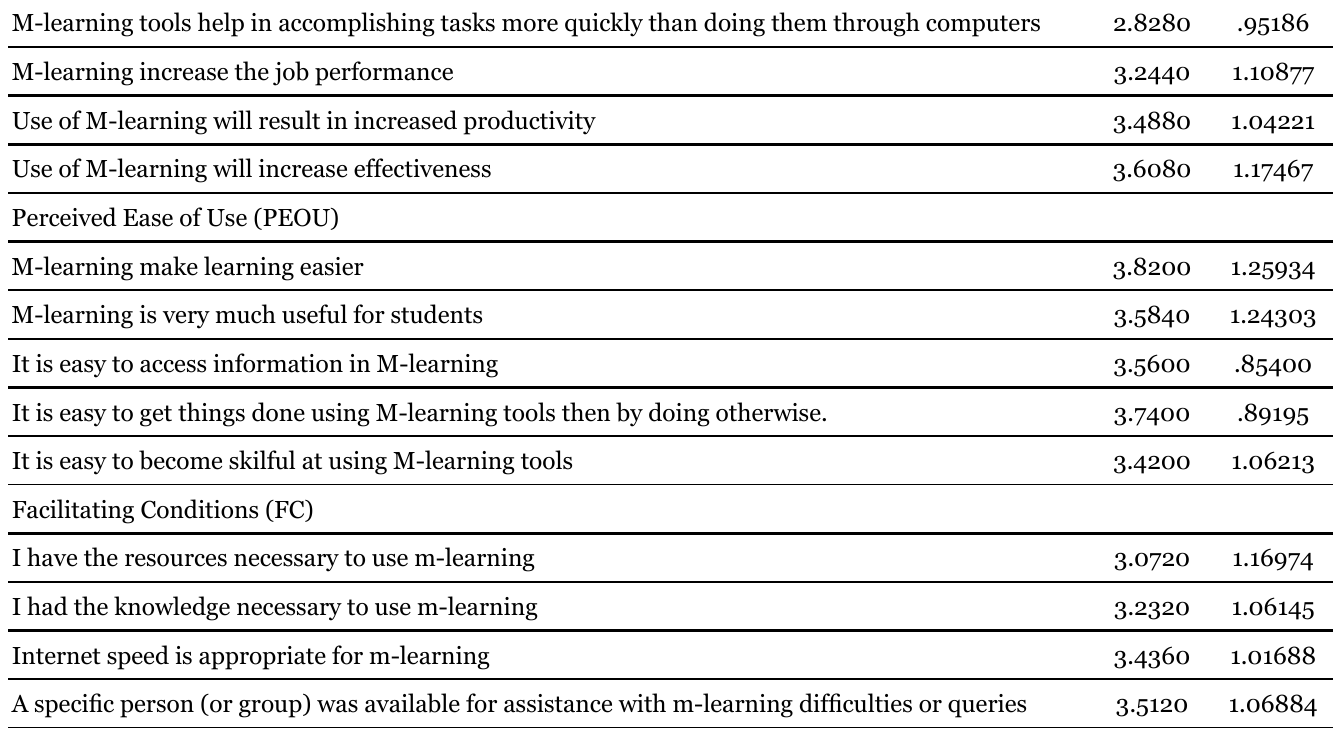
Table 2 Descriptive Statistics of Factors affecting M-Learning Perceived Usefulness